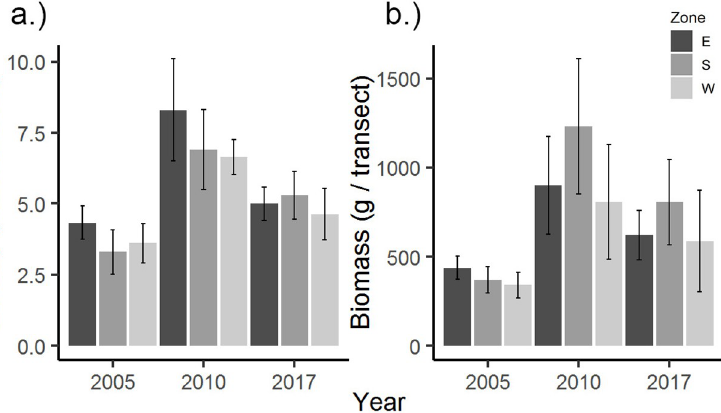
Fig 3. Density and biomass trends from the MNTZ by year and zone. Mean total transect density (a) (fish / 60 m 2 transect) and biomass (b) (grams / 60 m 2 transect) by year and zone from the MNTZ, with standard error bars indicated. Level of significance: � p < 0.05; �� p < 0.01; ��� p <